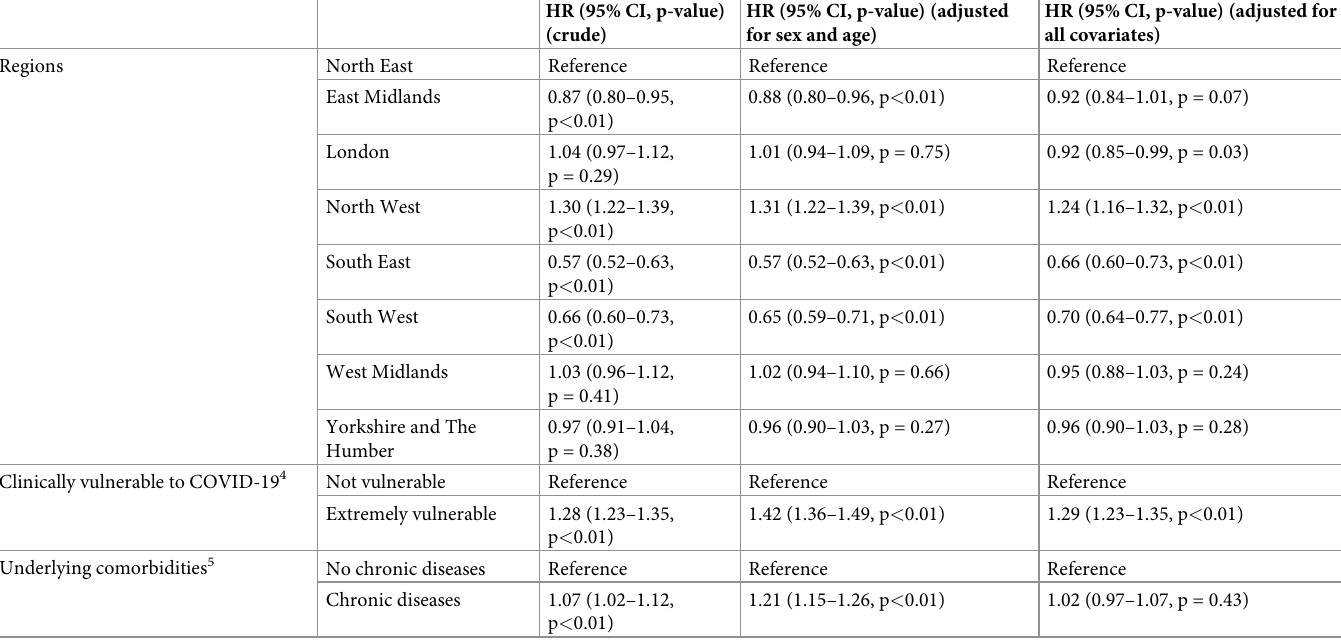
CI = 1.03–1.19), but in non-summertime months, only the vitamin D insufficiency group had a higher hazard of COVID-19 (insufficiency: crude HR = 1.15, CI = 1.02–1.31.) The results of the partially adjusted model were similar: only vitamin D deficiency in non-summertime was associated with an increased hazard of COVID-19 (HR = 1.15, CI = 1.02–1.31). After adjusting for all covariates, participants with vitamin D deficiency had a 14% lower hazard of being diag- nosed with COVID-19 compared with people with sufficient vitamin D status in British sum- mertime months (HR = 0.86, CI = 0.77–0.95). In non-summertime months, the hazard of being diagnosed with COVID-19 was 14% higher among the vitamin D deficiency group (HR = 1.14, CI = 1.01–1.30). No evidence showed that vitamin D insufficiency was associated with COVID-19 during either summertime or non-summertime months. Being male, non- white, overweight or obese, more deprived, clinically vulnerable or with underlying comorbid- ities was associated with an increased hazard of being diagnosed with COVID-19, while people who were older than 70 years had a lower hazard of being diagnosed (Table 3).